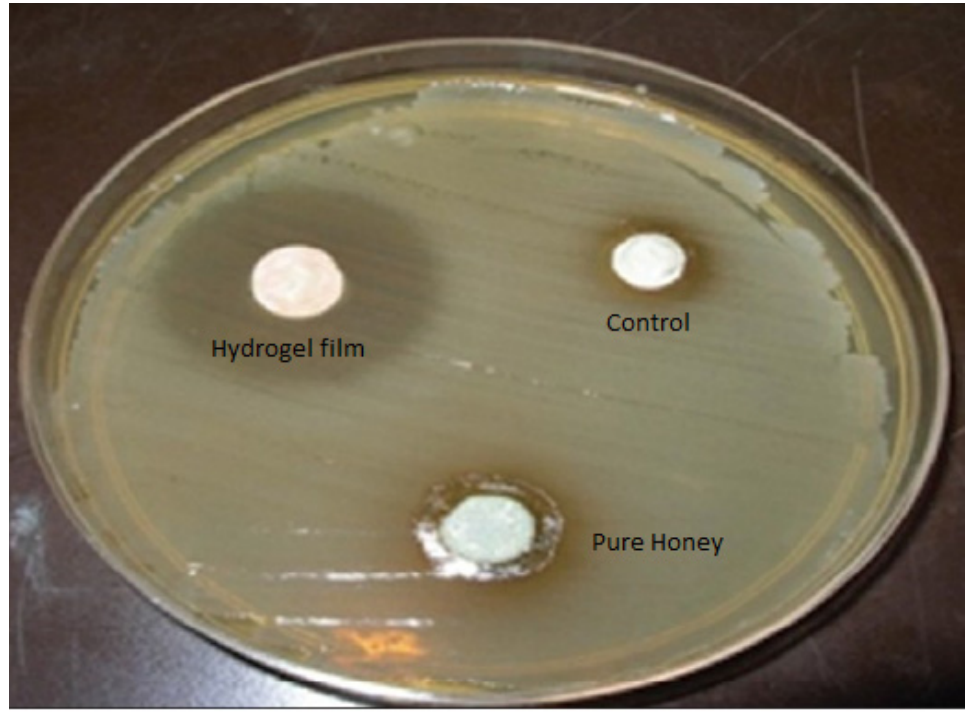
Figure 7. Microbial plates representing zone of inhibition for control, honey and hydrogel film.